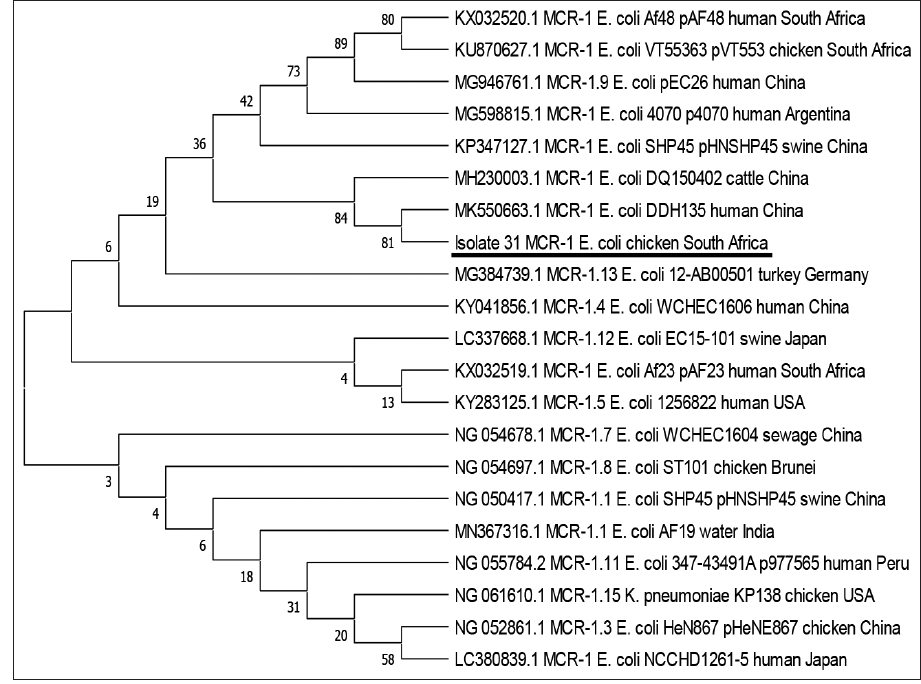
Figure-1: Evolutionary tree of mobilized colistin resistance ( mcr)-1 gene sequence obtained from the present study in comparison with sequences of other mcr-1